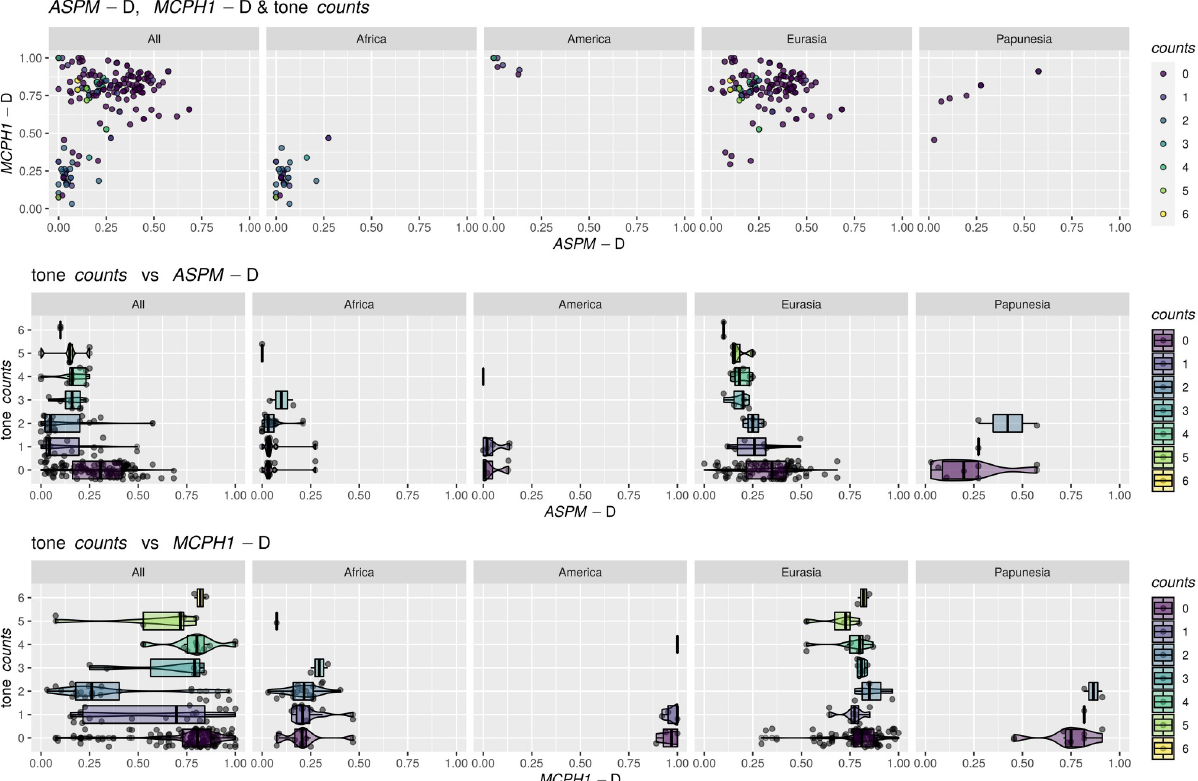
Fig 25. Relationship between tone counts and the population frequency of ASPM -D and MCPH1 -D in the whole database and separately by macroarea. Same conventions as in Fig 8.